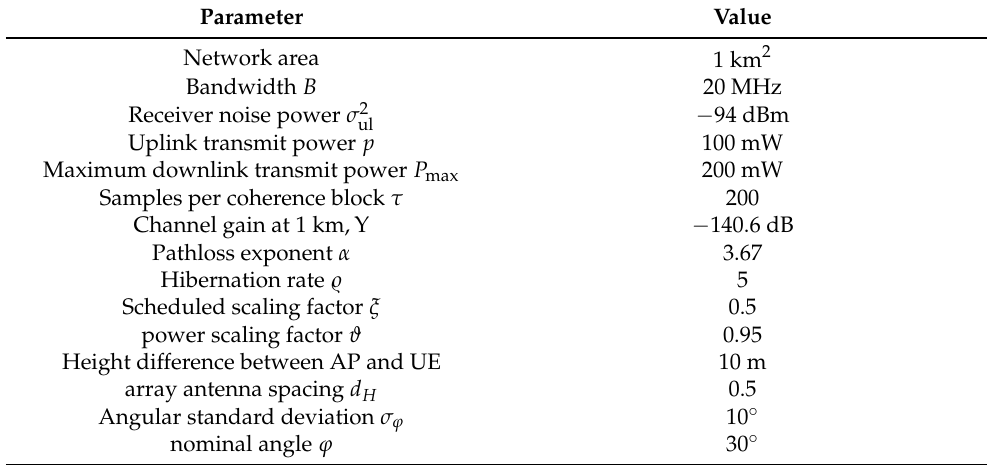
Table 1. Simulation parameter configuration. Parameter Value Network area 1 km